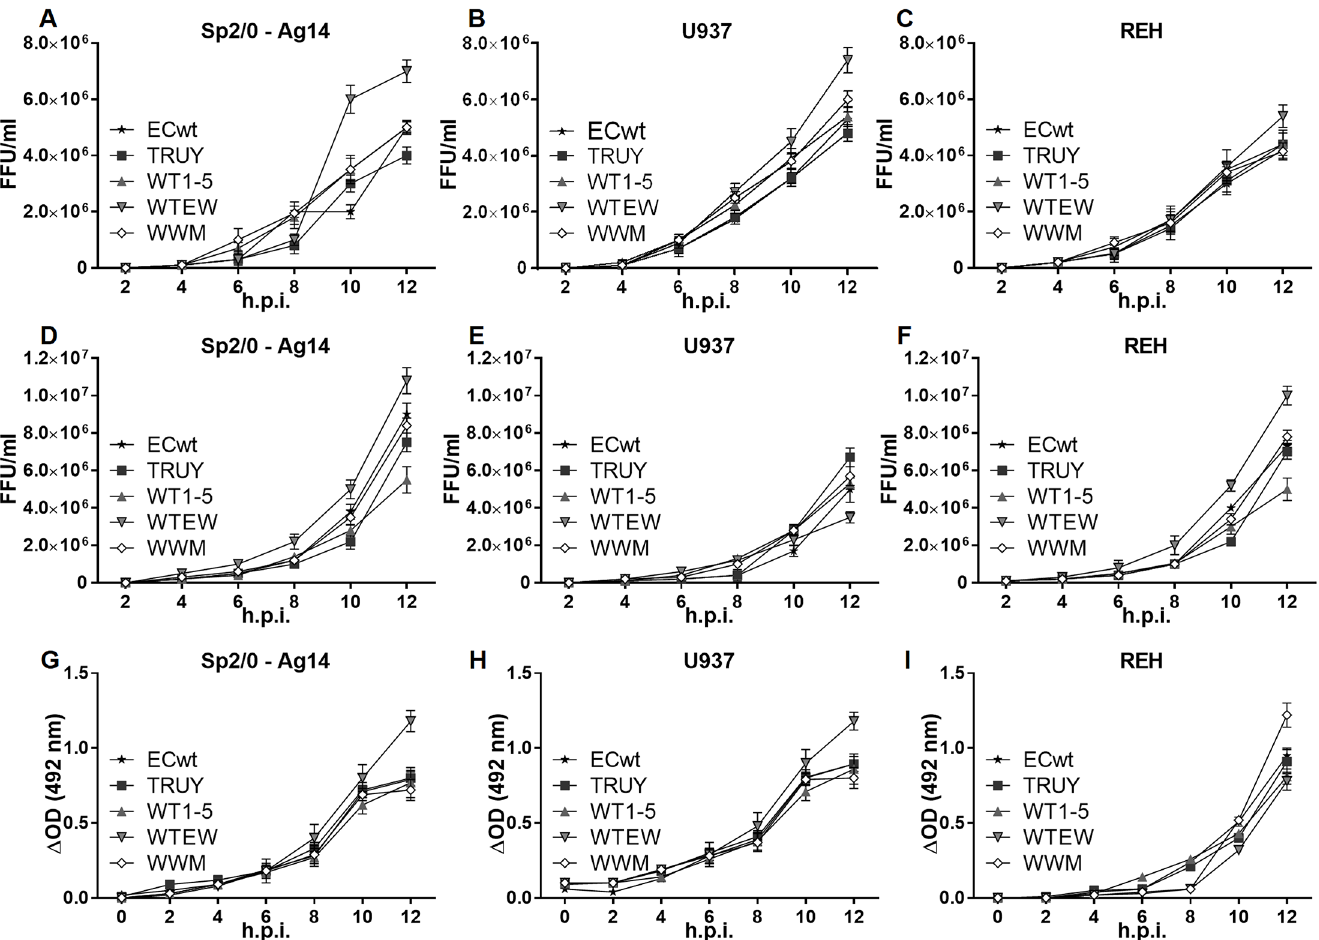
Fig 2. Time-course accumulation of infectious virions from tumor cell-adapted rotavirus isolates WTEW, TRUY, WT1-5, WWM and ECwt and accumulation of their viral structural proteins (SP). Titers of the rotavirus isolates indicated were determined using serial dilutions of infected cell lysates which were inoculated in the respective cell lines indicated. Titers are expressed in FFU/ml in the y-axis. Comparisons were performed by determining the dilution producing the infection of 50% of cells at 12 h.p.i. as determined by immunocytochemistry assay using antibodies against SP. The time-course accumulation of virus titer in cells Sp2/O-Ag14 (A) U937 (B) and REH (C) was followed by taking samples every 2 h until 12 h.p.i. for immunochemistry assay. Aliquots of the infected cells taken at the indicated post-infection times for A , B and C were frozen and thawed twice, and the supernatant of 700 g was activated with trypsin (10 μ g/ml) to be inoculated in new cells Sp2/O-Ag14 ( D ) U937 ( E ) and REH ( F ). After 12 h.p.i., the cells were analyzed for the production of infectious titer determined by the presence of rotavirus SP using immunochemistry assay. Statistically significant differences for infectious titers between ECwt and the combined rotavirus isolates are described in the Results section. The activated supernatant from infected cell lines Sp2/O-Ag14 (G) U937 (H) and REH (I) was also examined for the presence of viral SP at the indicated post-infection times using capture ELISA.